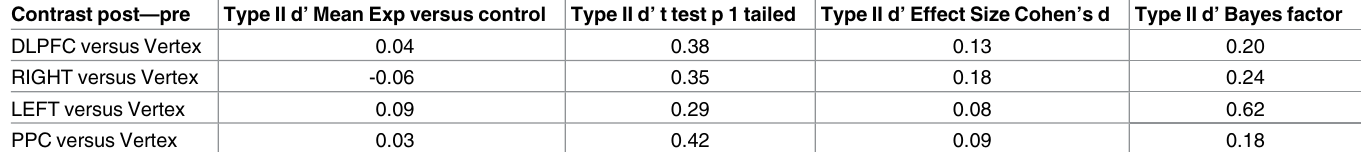
Table 3. Type II d’ table of t tests, effect sizes and Bayes factors analyses between conditions and control (NB no type II d’ results were reported in the Rounis study. Lower/upper bounds of averagetype II d’ scores were used instead). Contrast post—pre